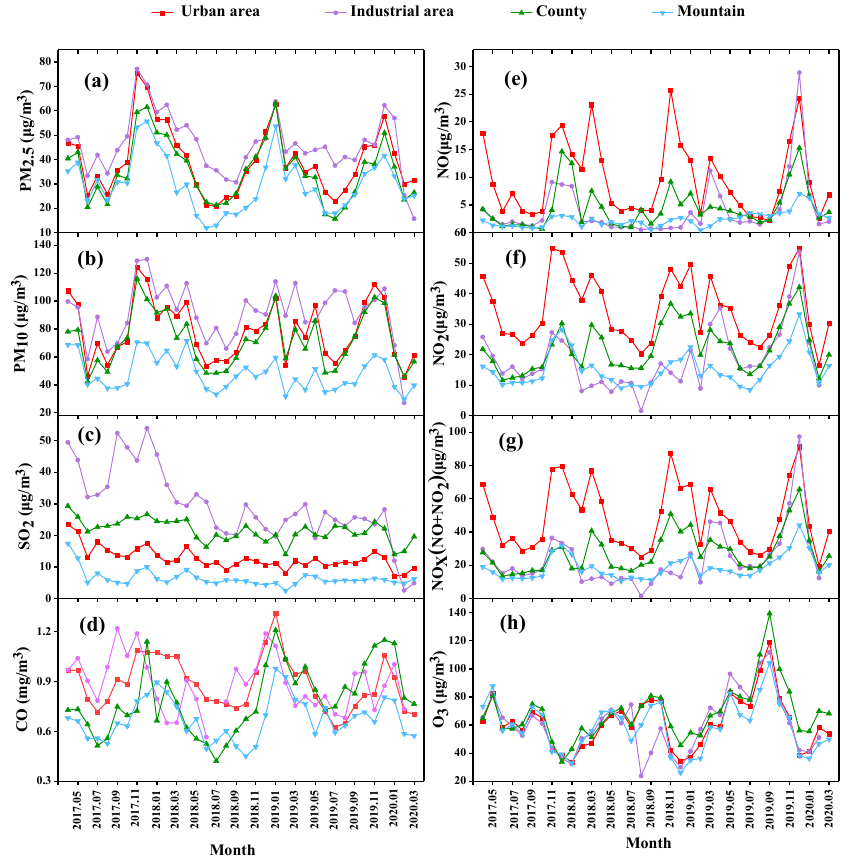
Figure 3. Monthly mean concentrations of air pollutants: ( a ) PM 2.5 ; ( b ) PM 10 ; ( c ) SO 2 ; ( d ) CO; ( e ) NO; ( f ) NO 2 ; ( g ) NOx (NO + NO 2 ); ( h ) O 3 .